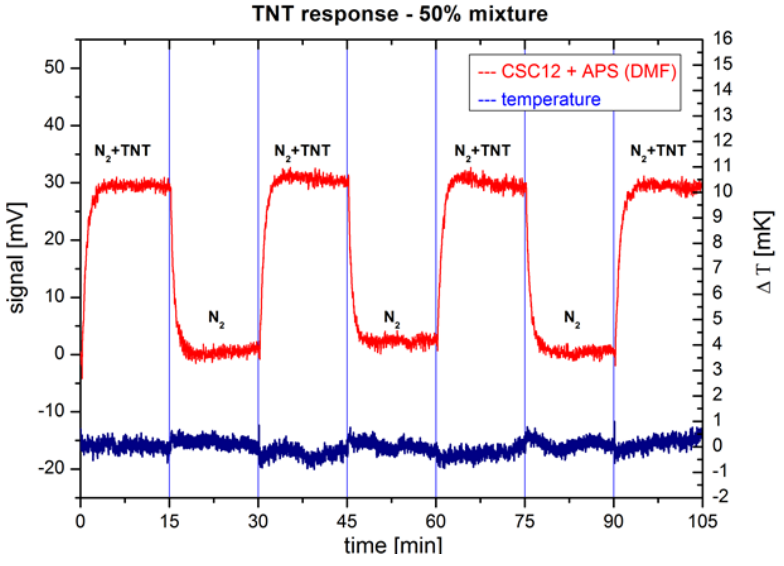
Figure 5. Measured responses of CSC12 cantilevers functionalized with APS molecules (red) on switching between pure N and mixture of N and 50% vapour pressure of TNT at 2 2 room temperature. Temperature changes in the system (blue) due to switching between the two gases are below 1